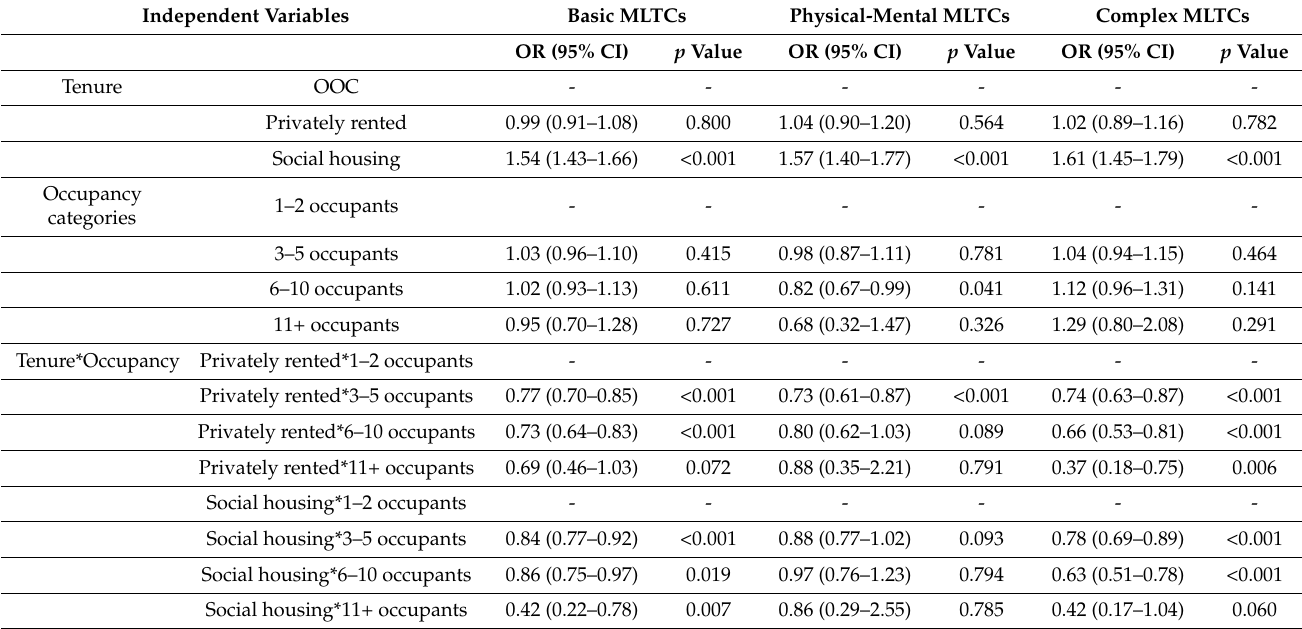
Table A5. Estimated odds ratios of basic, physical-mental, and complex MLTCs with household tenure when the final models tested for interactions between tenure and household occupancy for working-age adults residing in B&D in 2019/20 (N = 102,430).